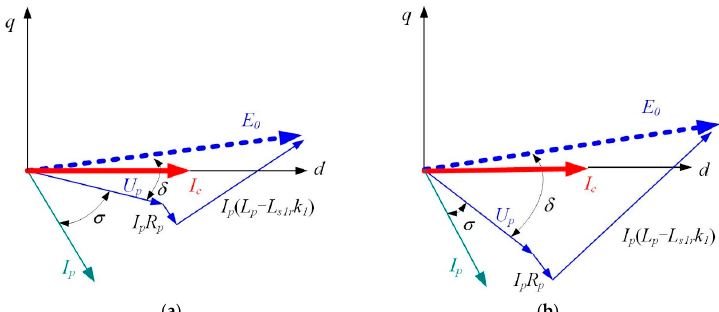
Figure 3. The vector diagrams before and after operation point changes. ( a ) Before the adjustment; ( b ) After the